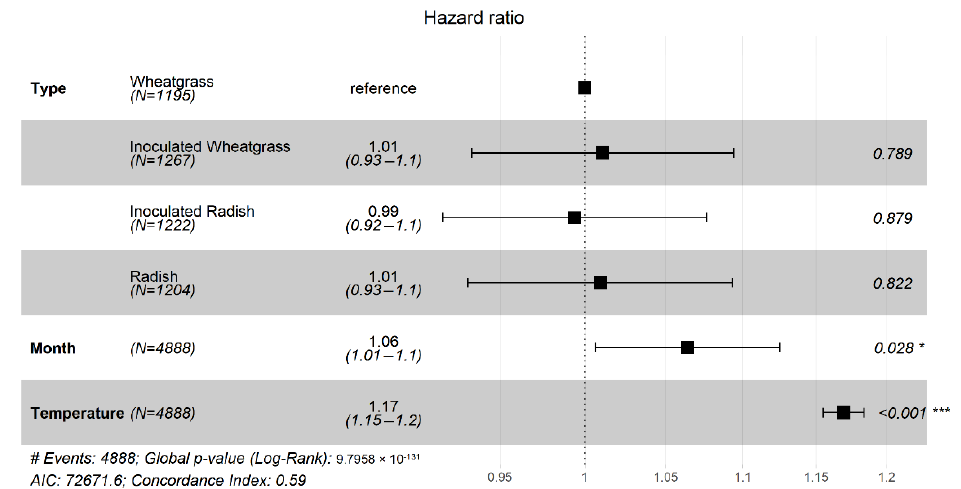
Figure 7. Hazard ratio test demonstrating differences in preferences between inoculated and uninoculated seed types. Reference is wheatgrass. Means and standard errors on the right side of the chart indicate a larger number of seeds that were removed during the trial compared to wheatgrass (control), June (month), and 28 ◦ C (temperature). Differences in month n (observed seed number) were due to differences in numbers of trials per month and temperatures at the time of seed count as well as censorship due to external events. Expanded hazard ratios for month and temperature can be seen in the supplemental material (Figure S3). Asterisks indicate the relative p- values indicating statistical significance where * indicates p <0.05 and *** indicates p <0.001.